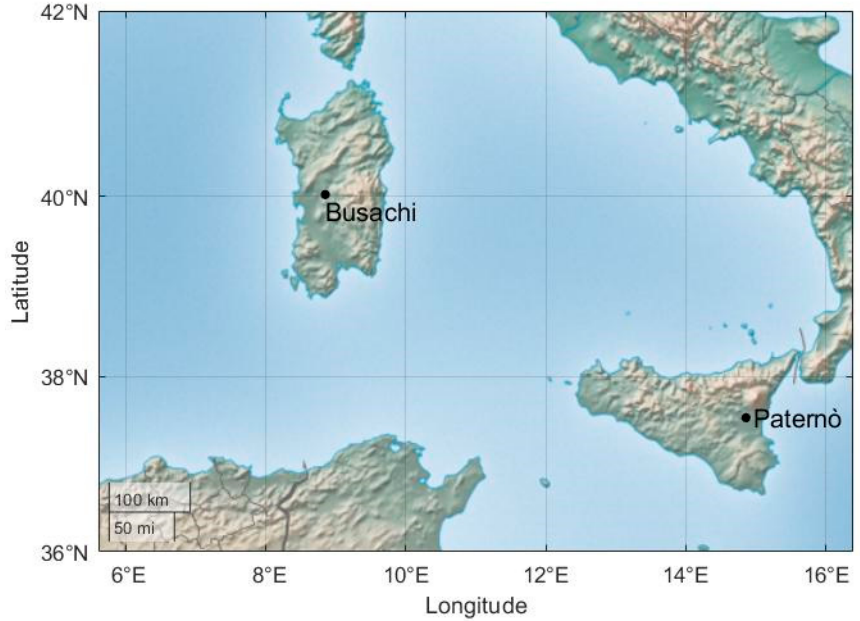
Figure 1. Map showing the geographical locations of the two Italian case studies Patern ò (Sicily) and Busachi